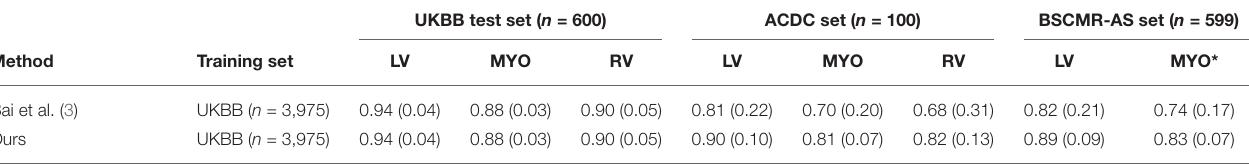
TABLE 3 | Comparison results of segmentation performance between a baseline method and the proposed method across three test sets.